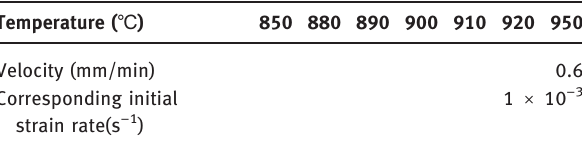
Table 1: The tensile temperature parameters of the tensile tests.